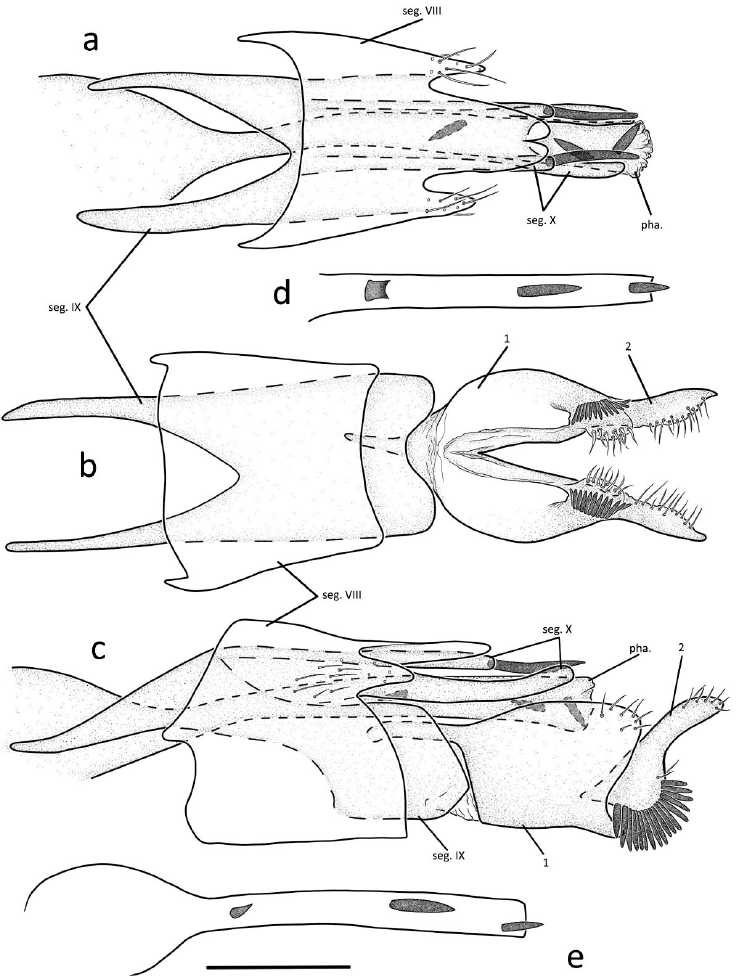
Figure 3. Male genitalia of Gunungiella flabellata , Peng, Ge and Sun n. sp., ( a – c ) 1 male Holotype specimen, and 7 males from Fu ‐ jian, Da ‐ zhu ‐ lan; ( d , e ) 1 male from Fu ‐ jian, Lao ‐ wu farm: ( a ) dorsal; ( b ) ventral; ( c ) left lateral; ( d ) phallus, dorsal; ( e ) phallus, left lateral. Abbreviations: seg. VIII = segment VIII; seg. IX = segment IX; seg. X = segment X; 1 = first article (paired); 2 = second